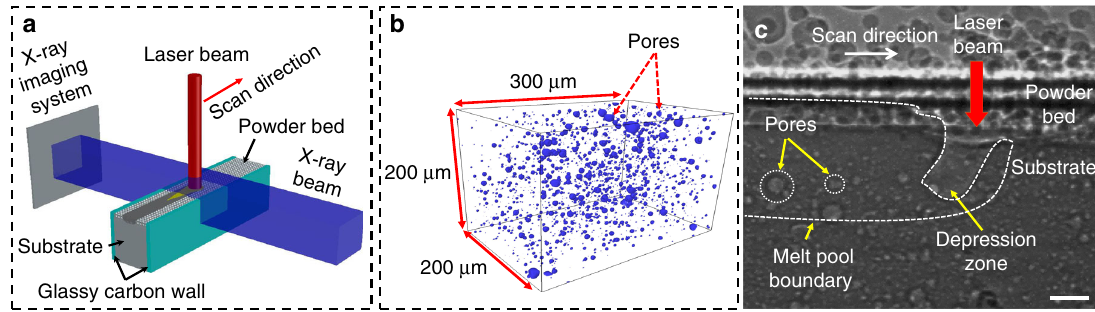
Fig. 1 In-situ characterization of pore dynamics during LPBF process. a Schematic illustration of the in-situ high-speed X-ray imaging experiment. b Representative cuboid (300 µ m × 200 µ m × 200 µ m) reconstructed from X-ray computed tomography data showing the size and distribution of pores inside an additively manufactured AlSi10Mg plate. c Representative single-pulse X-ray image revealing micro-pores as well as the melt pool and depression zone beneath the surface of the powder bed (laser power of 360 W, scan speed of 1 m s − 1 and laser beam diameter ( D 4 σ ) of 100 μ m). The boundaries of the melt pool and the depression zone are indicated by a white dashed line, and the position of the laser is indicated by a red arrow. The scale bar